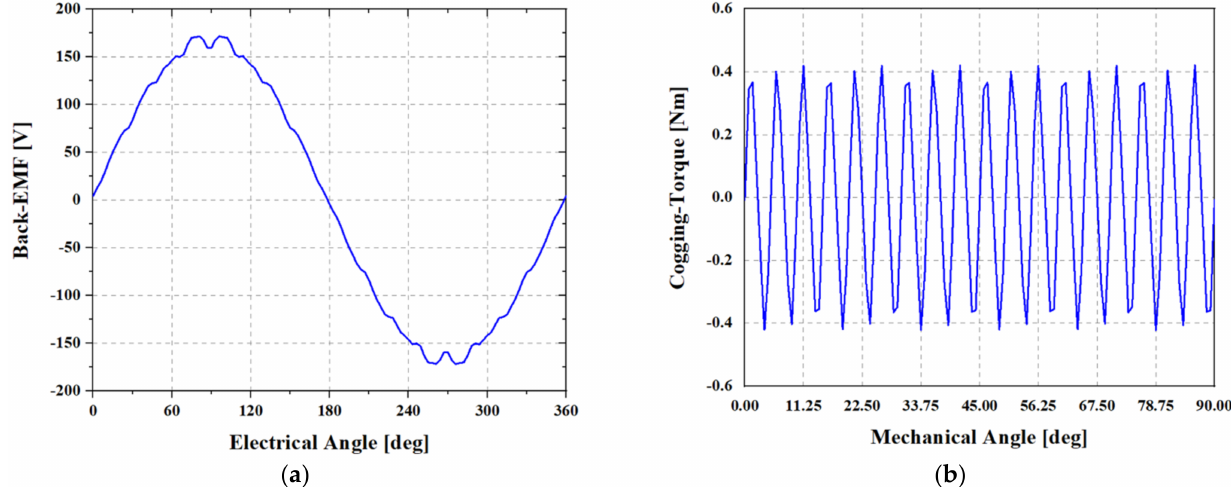
Figure 15. Topology of the optimal model.